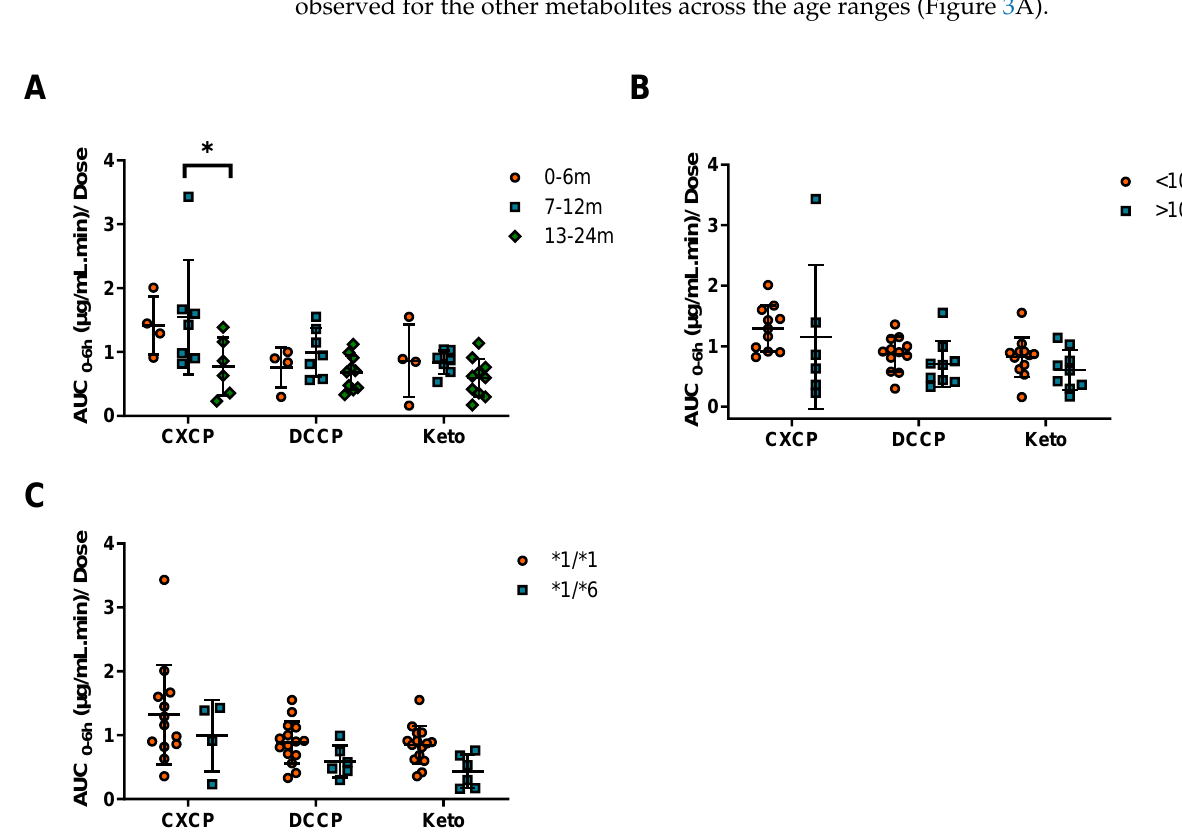
Figure 3. The impact of ( A ) age, ( B ) weight and ( C ) CYP2B6 genotype, on cyclophosphamide dose normalized exposure (AUC 0–6h ) of cyclophosphamide metabolites. * Indicates a significance level of p <0.05.